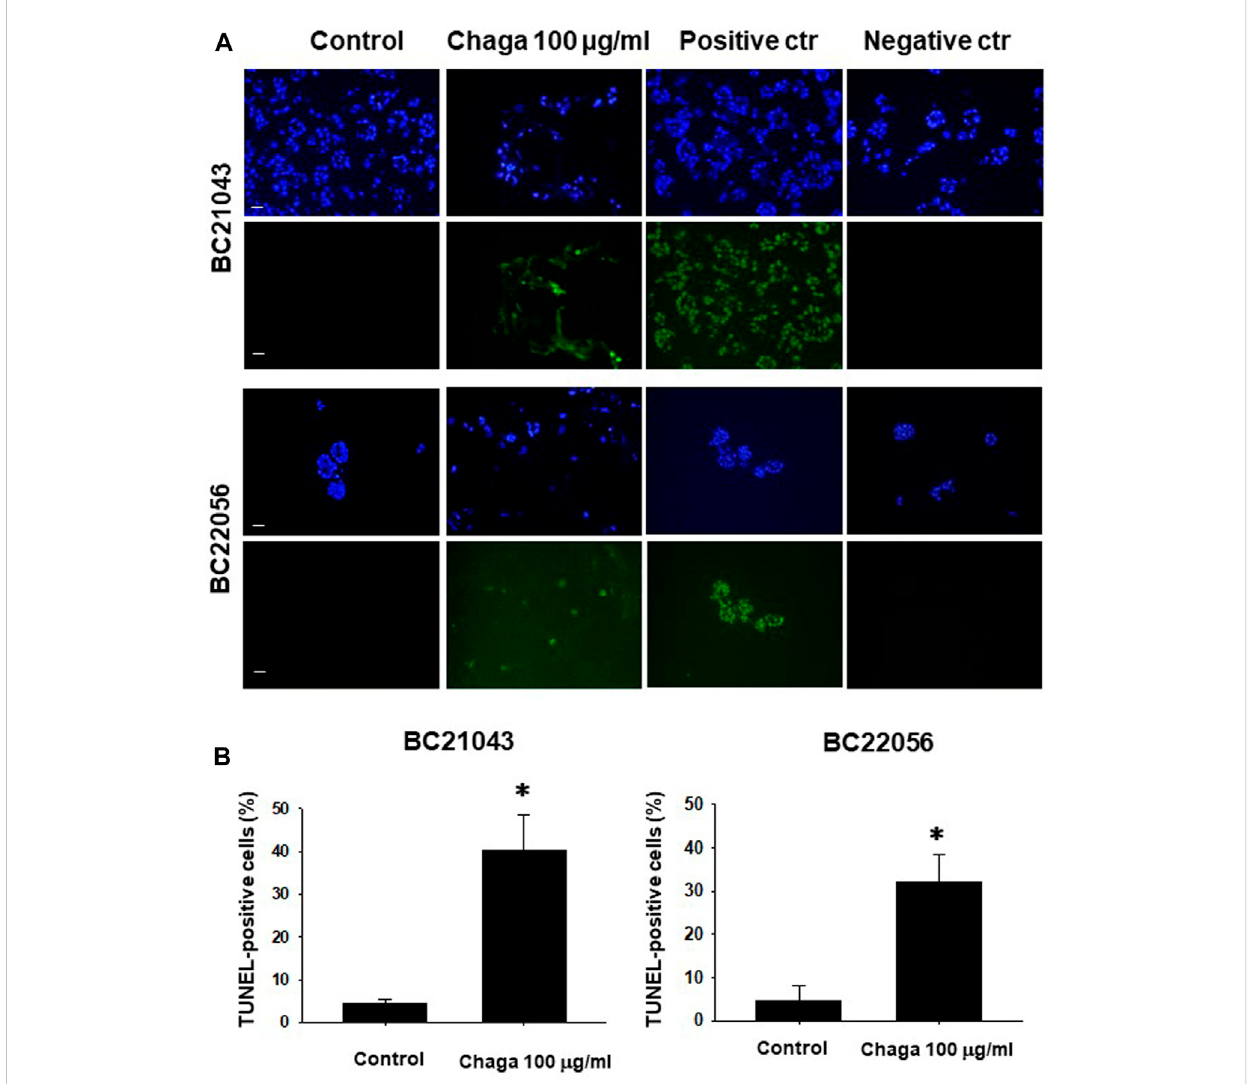
FIGURE 3 EffectsofChagaonapoptosisinDBCO.TUNELstainingoffrozensections(8 μ mthickness)oftwostrainsofDBCO(BC21043andBC22056)treated with Chaga (100 μ g/ml for 72 h). DNase-treated organoid cells were used as the positive control (n = 3). PBS-treated organoid cells were used as the negativecontrol(n=3).Thegreen fl